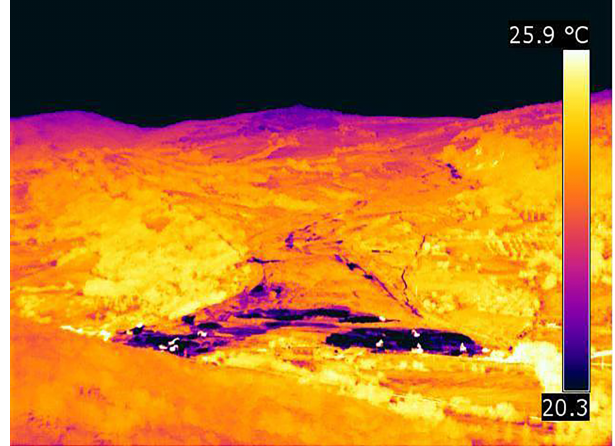
Figure 8. Thermal image of the Montaguto earthflow from the GB- InSAR installation point (acquisition time: 11 May 2010, 11:00); dark pixels correspond to wet areas. For scale reference, the toe is 400m large and the white dots on the wet areas are bulldozers reshaping the